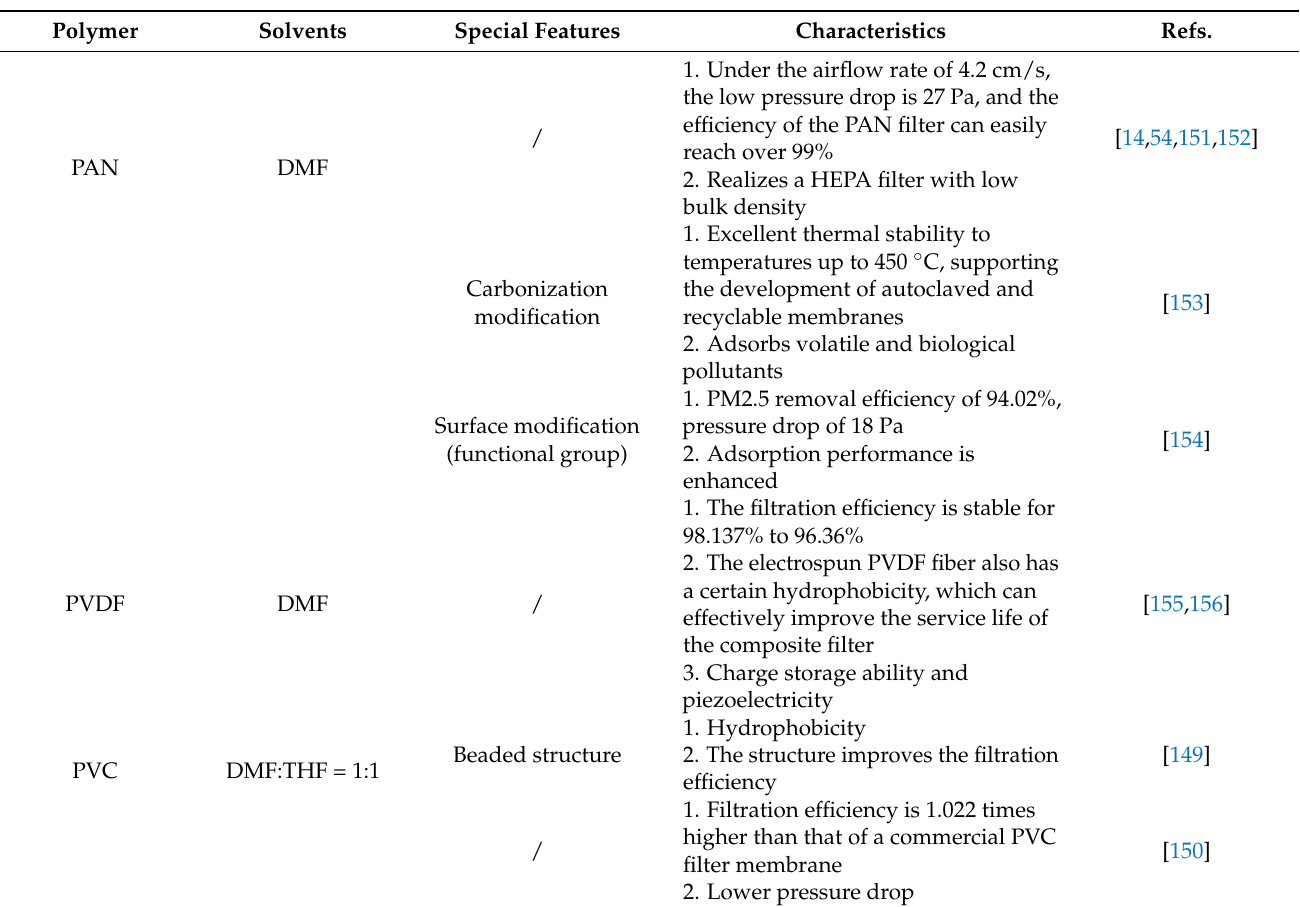
Table 2. Common pure polymer air-filter membranes prepared by electrospinning. Polymer Solvents Special Features Characteristics